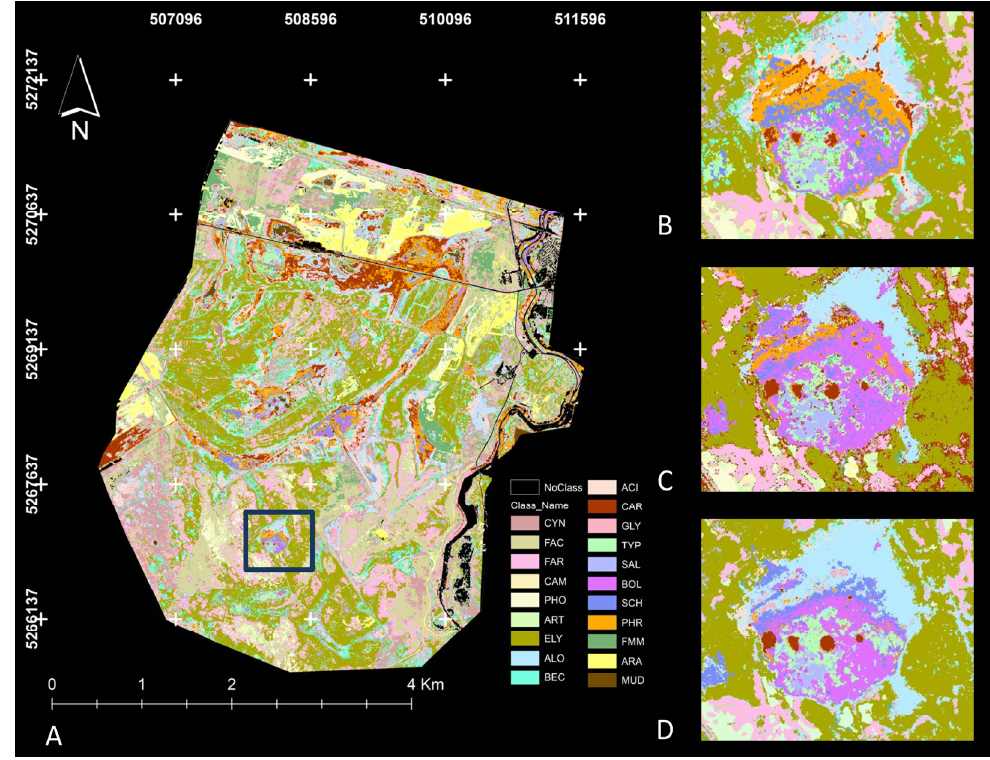
Figure 10. Vegetation map ( A ) of the study site produced using SVM classification with 30 random training pixels per class. Detailed maps produced by SVM ( B ), RF ( C ) and MLC ( D ) classification are provided in the subset image (right